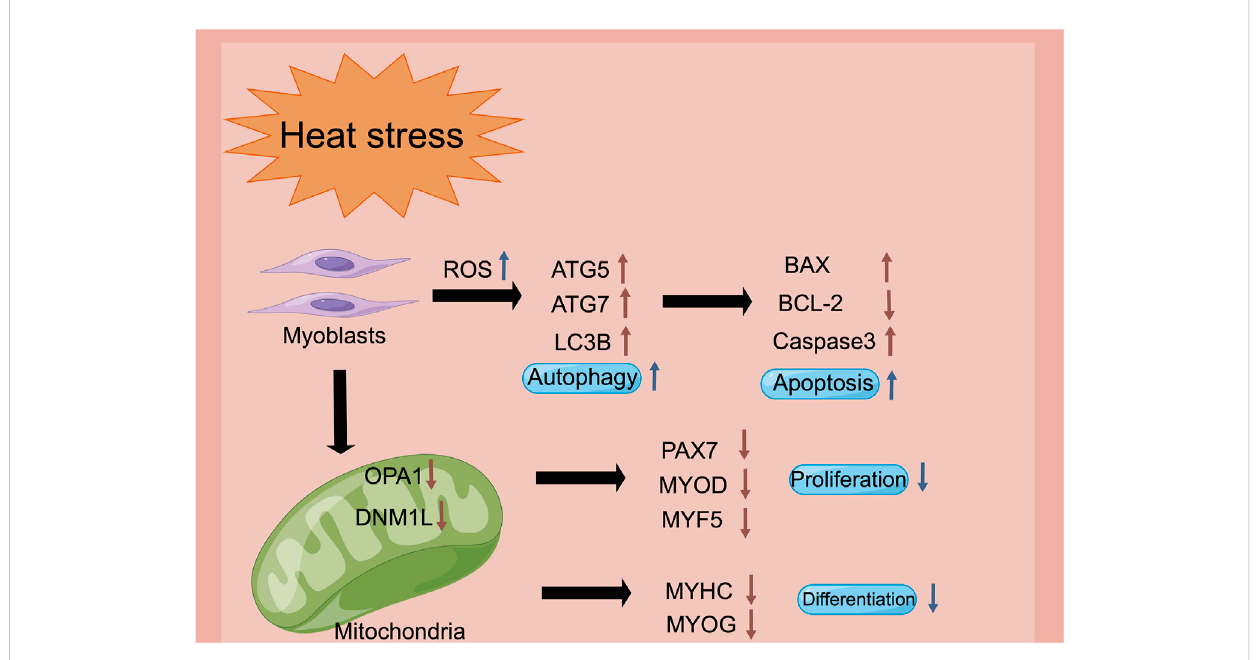
FIGURE 7 Theschematicdiagramofheatstressmodulatesthebiologicalprocessesofmyoblasts via theregulationofthemitochondrialfunction( fi guremade by Figdraw). Heat stress impairs mitochondrial biogenesis and function, stimulation of the intracellular reactive oxygen species, and decrease of the mitochondrial membrane potential, which may be the reason for the inhibition of proliferation, differentiation and cell migration in the